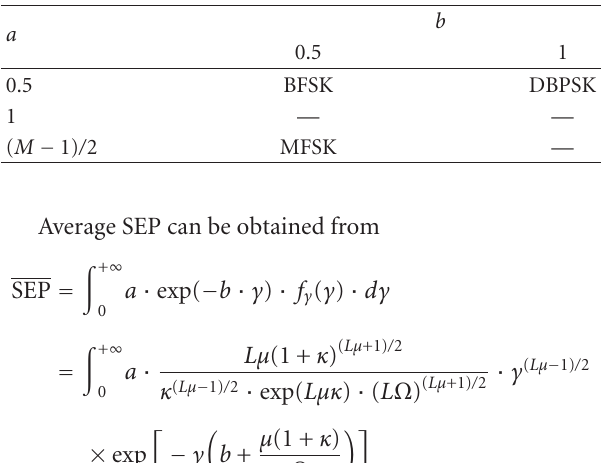
Figure 9: BEP/SEP for noncoherent detection, no diversity. Table 1: Values of a and b for some noncoherent modulations.